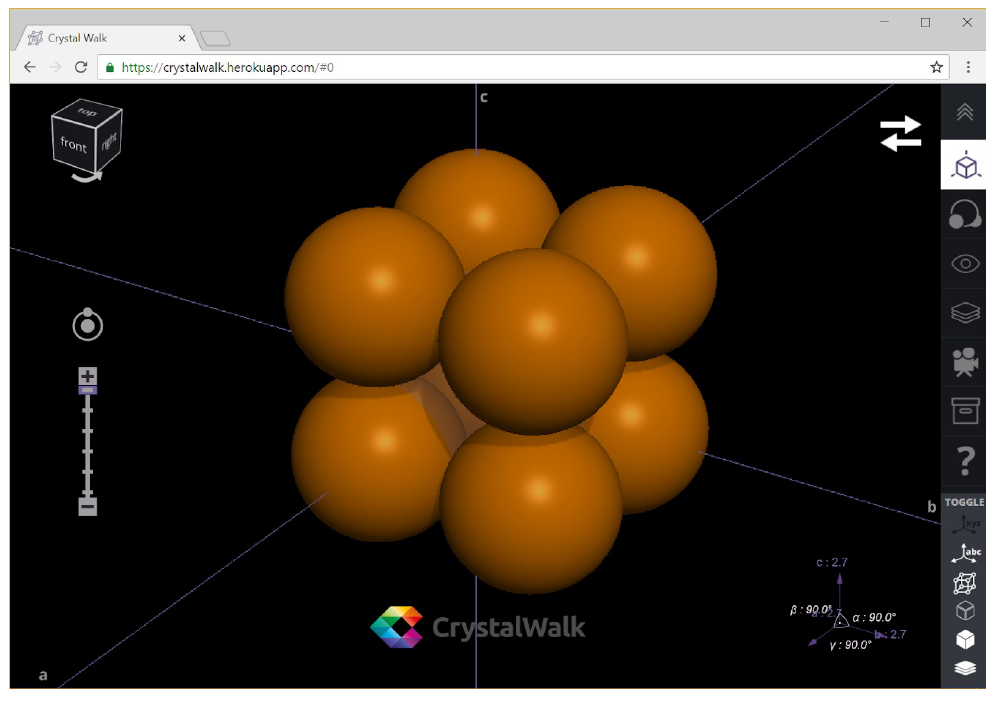
Figure 6. Screenshot of CWAPP interface running on a browser. Source: [8].